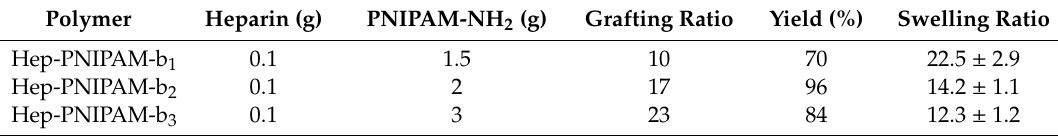
Table 1. Polymer grafting e ffi ciency and swelling